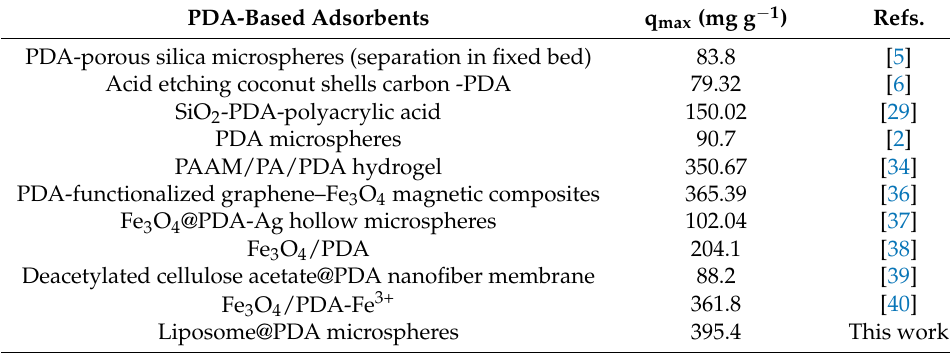
Table 1. Comparison of adsorption capacities of different PDA-based adsorbents for MB removal at 298 K. PDA-Based Adsorbents